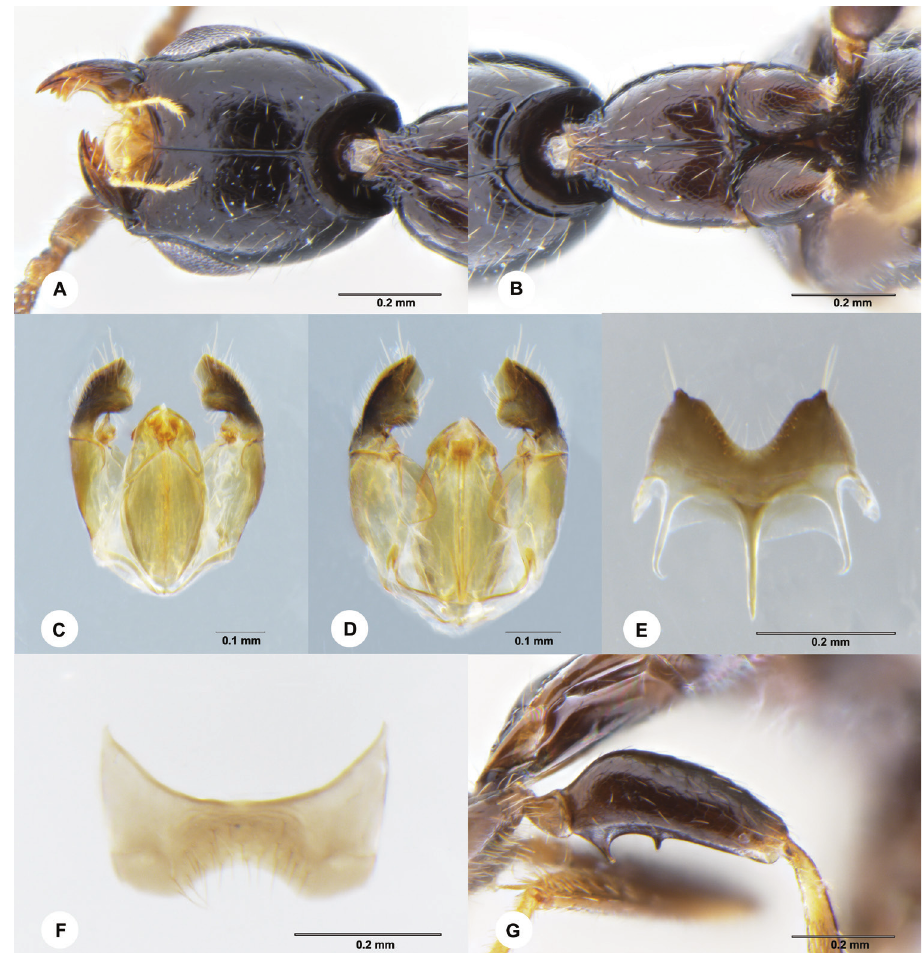
Figure 7. Foenobethylus yunkaishanensis Chen & Luo, sp. nov., male A, B, G holotype (SCAU 3048315), C–F paratype (SCAU 3042639) A head, ventral view B mesosoma, ventral view C genitalia, dorsal view D genitalia, ventral view E subgenital plate F 7 th sternite G metaleg, lateral